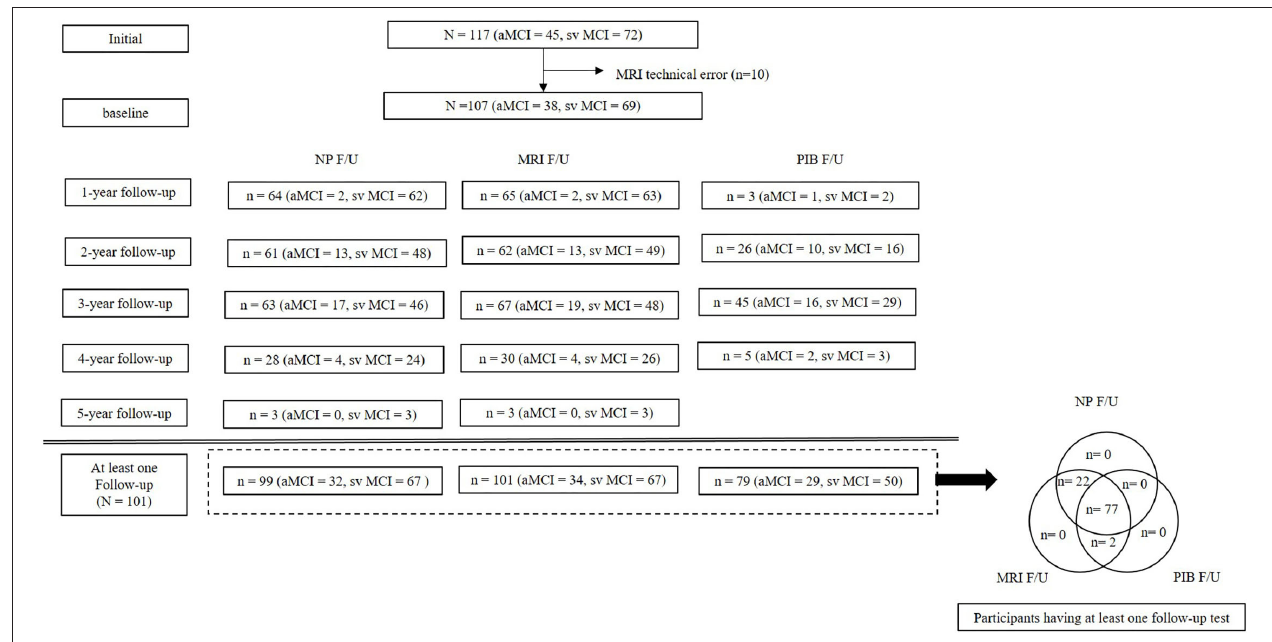
FIGURE 1 | Participant flow diagram. MRI, Magnetic resonance imaging; NP, neuropsychological tests; PIB, Pittsburgh compound B.